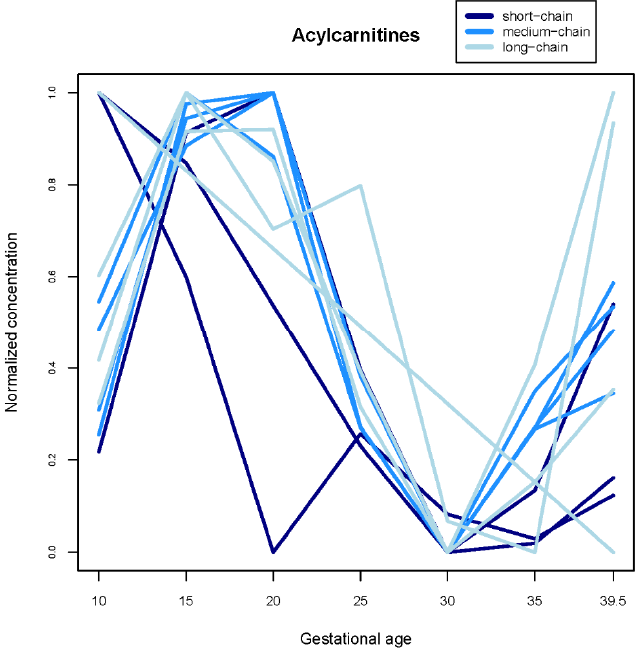
Figure 1. Trajectories of normalized acylcarnitine concentrations estimated from linear mixed models with 5-knot penalized splines. Short-chain acylcarnitines have 2–4 carbon chains, medium-chain acylcarnitines have 8–12 carbon chains, and long chain acylcarnitines have 14–18 carbon chains. Metabolites with the same trajectory are plotted as a single line. Absolute concentrations of each individual acylcarnitine ( n = 15) are plotted in the Supplemental Material.